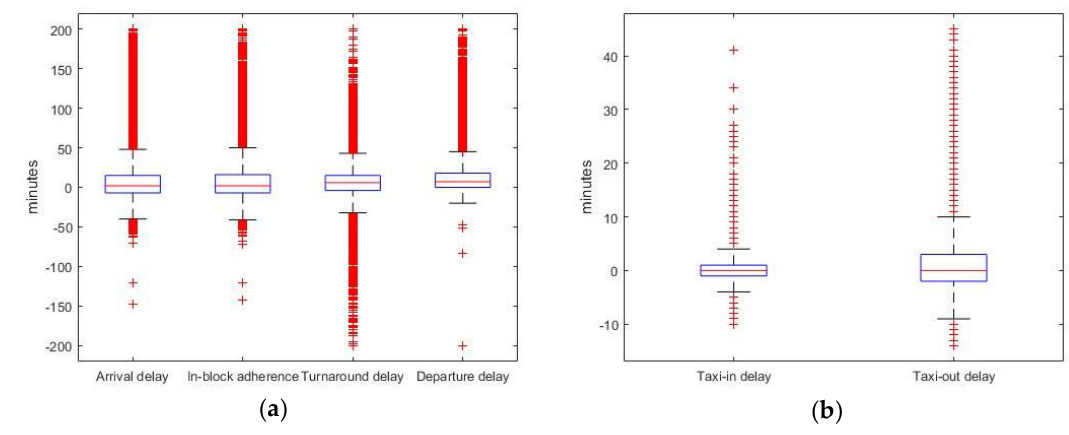
Figure 22. Boxplot for ( a ) arrival delay, in-block adherence, turnaround delay and departure delay; and ( b ) taxi-in delay and taxi-out delay.